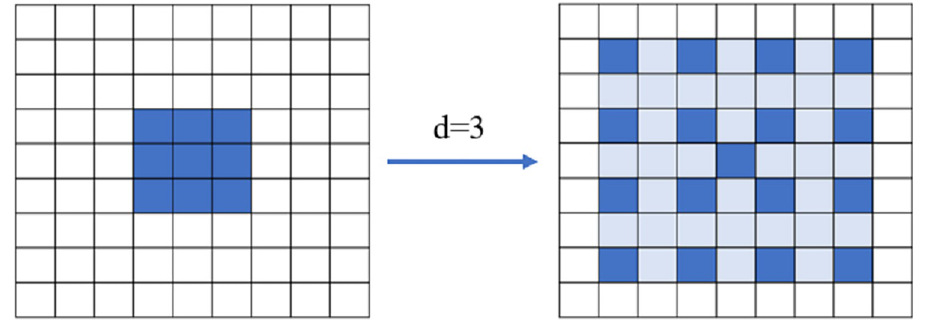
Fig 3. Dilated convolution of 7 × 7 size used in the